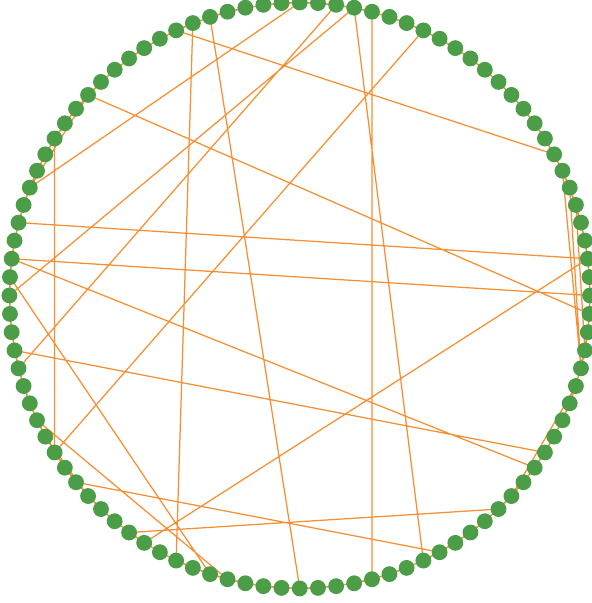
Figure 2: A synthetic small-world network